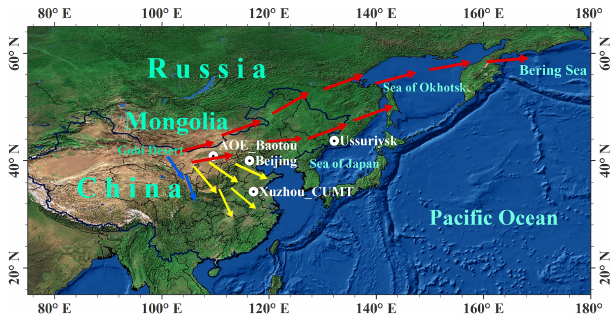
Figure 1. Illustration of the May 2017 dust event. The white circles with black points represent four AERONET stations and the arrows show the dust transport